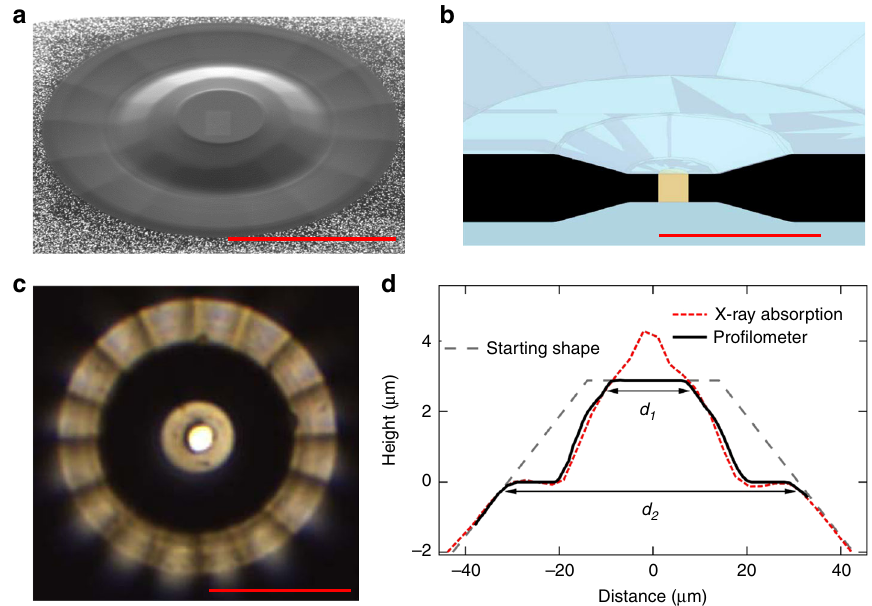
Fig. 1 Geometry of the optimized toroidal shape used in runs 1 – 4. a Scanning electron micrograph picture. b Sketch of the sample chamber in toroidal-DAC. The sample and gasket are represented in yellow and black, respectively. c Picture of the aluminum sample in run 4. The sample chamber in the center has been drilled with focused ion beam. The central fl at, diameter d 1 = 16 μ m, is shiny. The groove has a total extension d 2 = 60 μ m and appears black for the inner part and shiny for the outer (almost horizontal) part. d Pro fi le of the diamond tip measured with a pro fi lometer. The raw X-ray absorption pro fi le measured with λ = 0.3738 Å (see Methods section) is also plotted. d 1 and d 2 are the toroidal pit inner and outer diameters. The red scale bars all indicate 30 μ